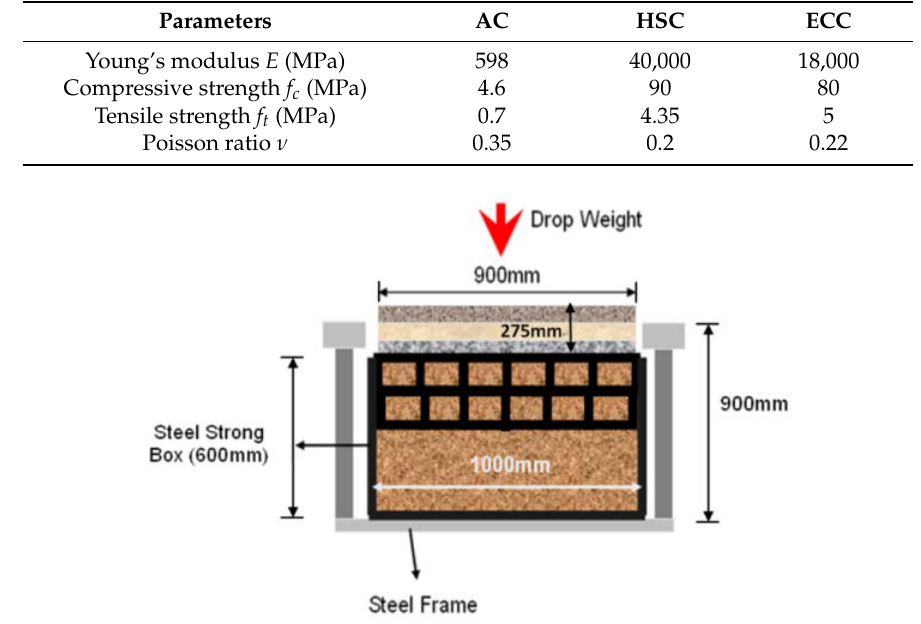
Figure 13. Setup for the impact test.